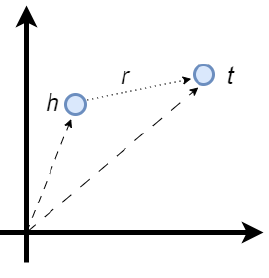
Figure 3. Embedding space representation of a single triple ( h , r , t )